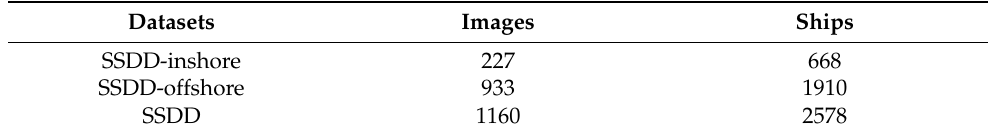
Table 3. SSDD-inshore and SSDD-offshore.